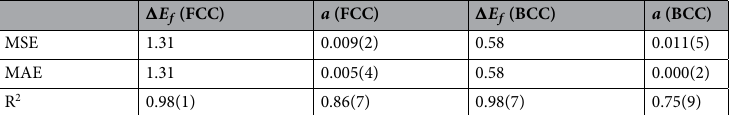
Table 2. MSE, MAE, and R 2 of formation energy ( (cid:31) E f ) and lattice parameters ( a ) for the predicted PtPdCr XY , PtPdNiSn X , and PtPd